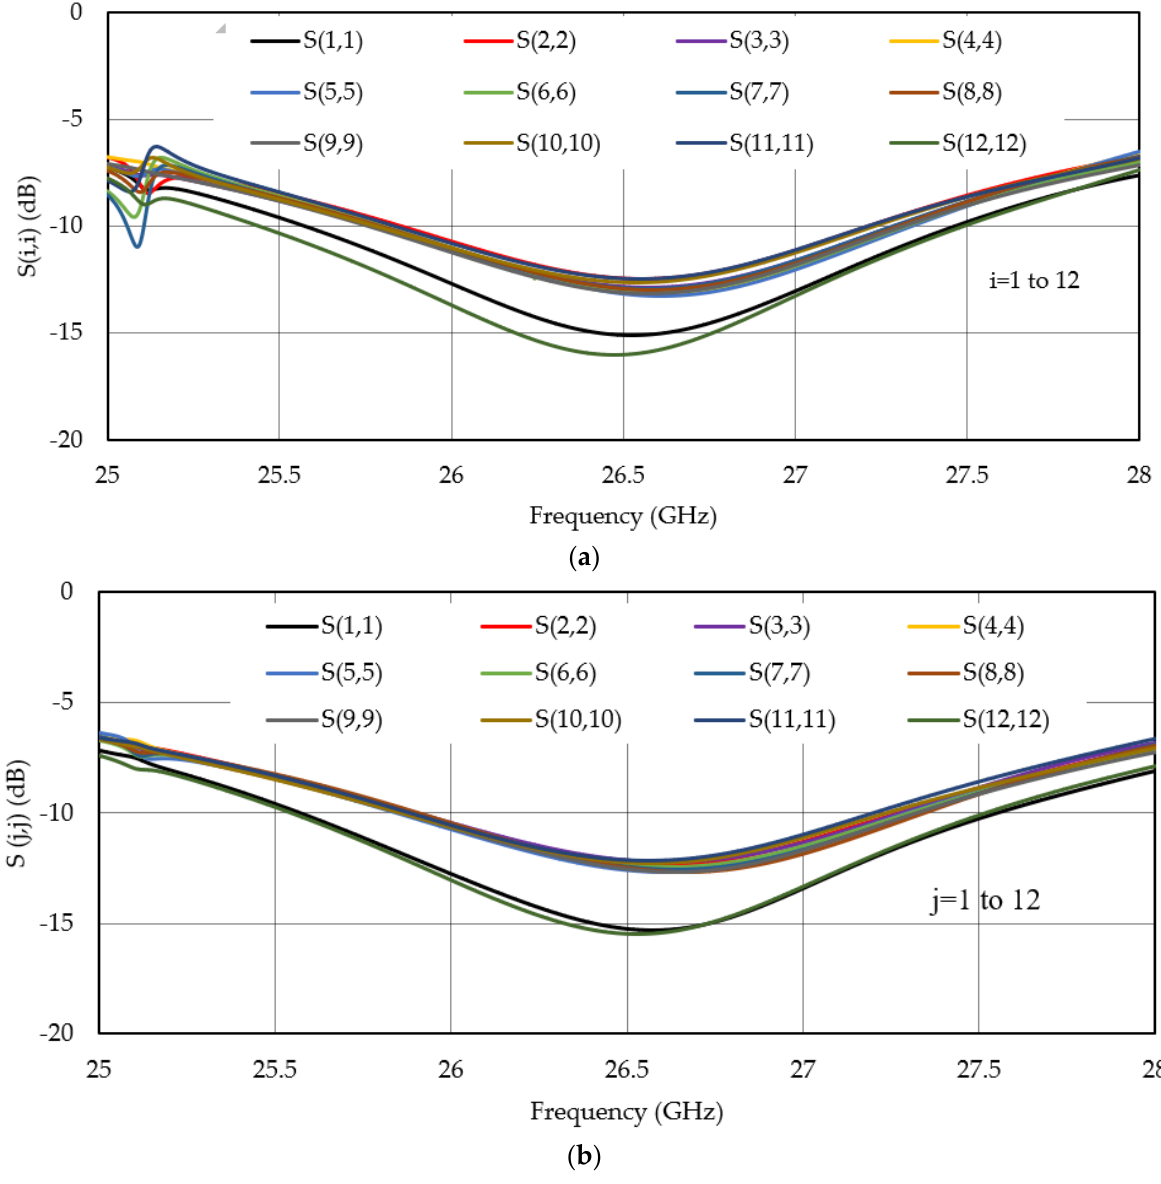
Figure 2. Scattering parameters: S(i,i) and S(j,j) of the antenna array elements for the ( a ) x − axis − oriented array and ( b ) y − axis − oriented array, respectively.